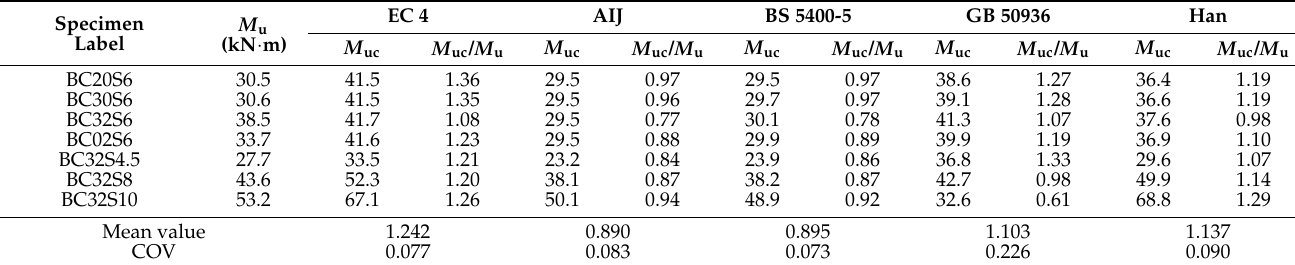
Table 10. Comparisons of the predictions and the test results for ultimate flexural